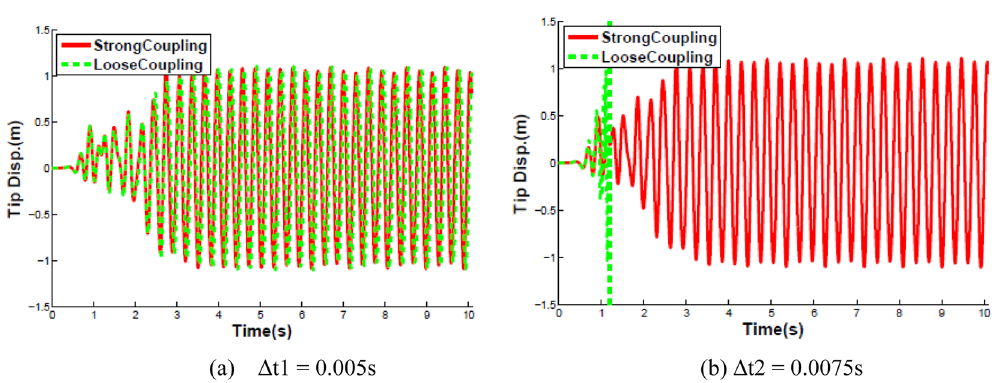
Figure 9. Verticals displacement at the tip of the beam with different coupling schemes.